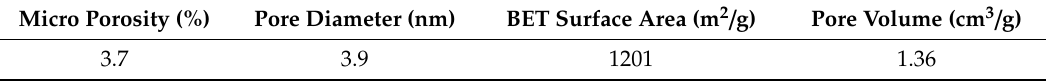
Table 1. Physical and chemical parameters of